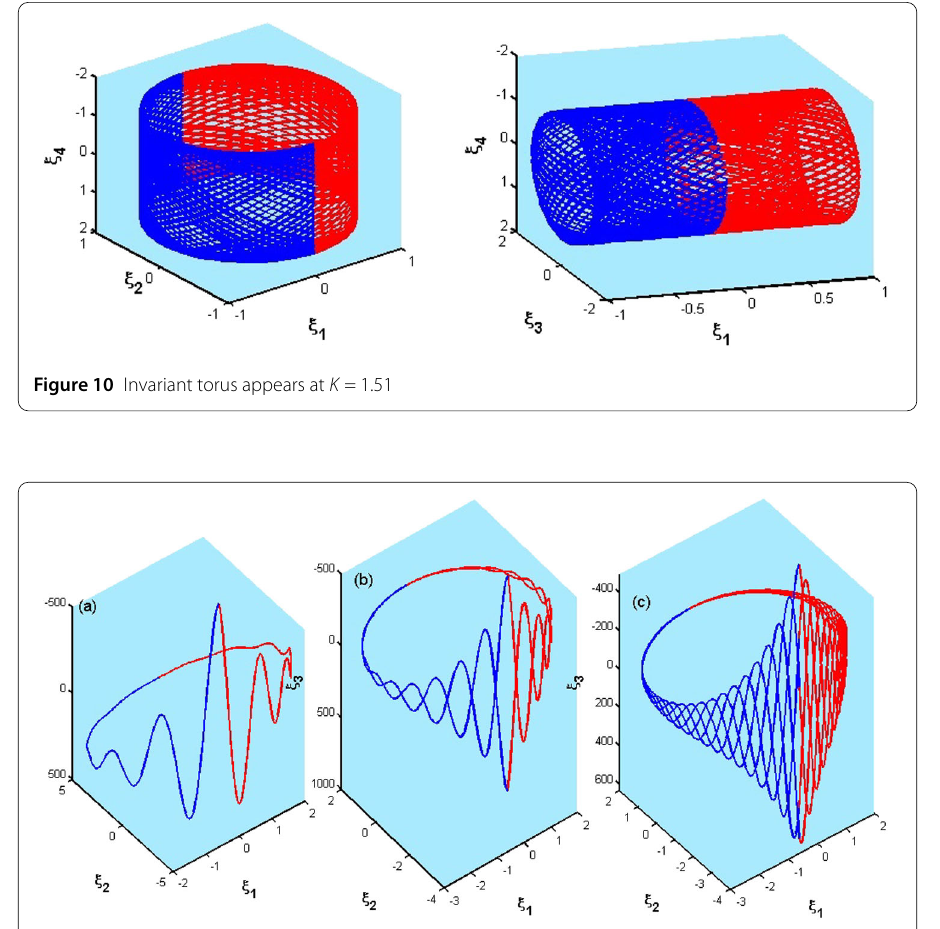
Figure 11 Transition from period-one orbit to period-two orbit and period-five orbit due to varying of K = 24, K = 25, and K = 24.4,